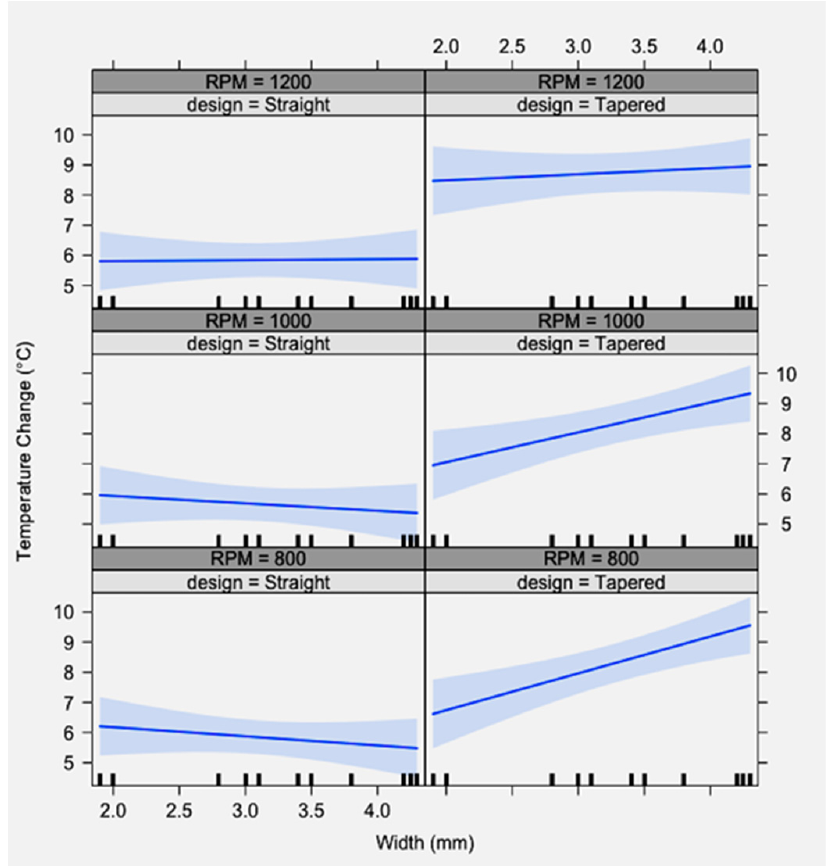
Figure 9. The Y -axis shows the temperature change ( ΔΤ ), and the X -axis shows the drill width. As drill diameter increased in a tapered design drill, ΔΤ increased. As the drill diameter increased in a straight design drill, ΔΤ remained constant or slightly